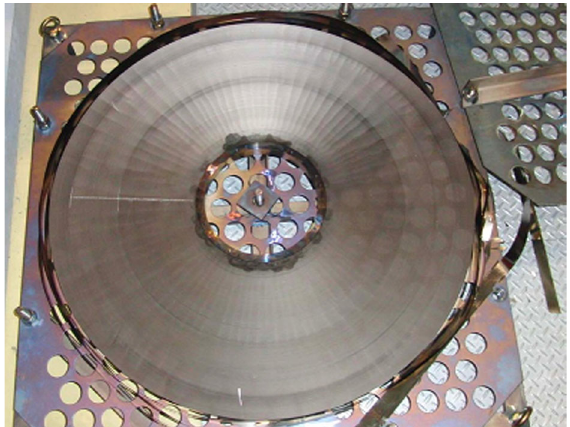
FIG. 5. The large size FT3L core annealed by the proof of principle system.